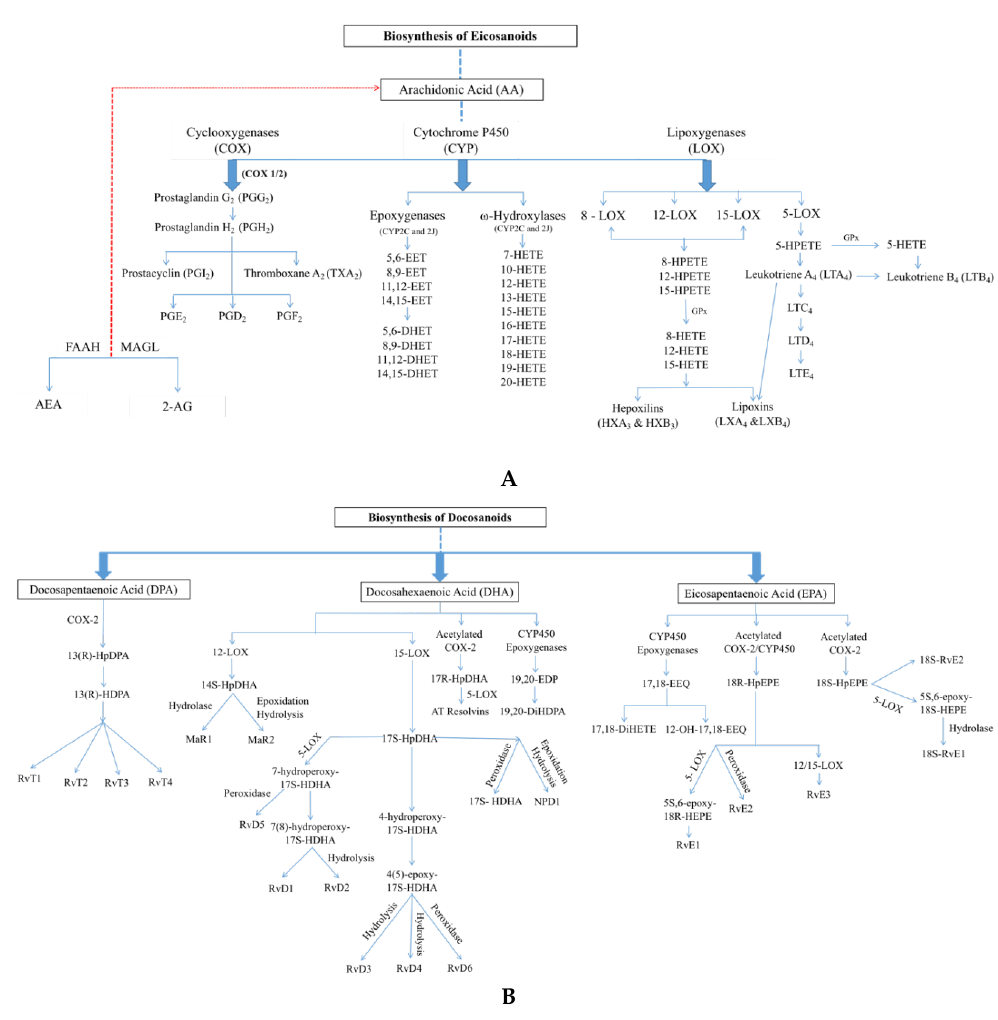
Figure 1. Biosynthesis of eicosanoids and docosanoids. ( A ) Eicosanoid biosynthesis starts with the release of arachidonic acid (AA) from membrane phospholipids and is catalyzed by three major enzyme families: cyclooxygenases (COXs), lipoxygenases (LOXs), and cytochrome P450 epoxygenases (CYPs). COXs produce prostaglandins (PGs) and thromboxanes (TXs) through the actions of specific synthases; LOXs produce biologically active metabolites, such as hydroperoxyeicosatetraenoic acids (HPETEs), hydroxyeicosatetraenoic acids (HETEs), and leukotrienes (LTs), while CYPs metabolize AA into epoxyeicosatrienoic acids (EETs), dihydroxyeicosatrienoic acids (DHETs), and HETEs. Arachidonic acid can be recycled from the breakdown of endocannabinoids through the actions of fatty acid amide hydrolase (FAAH) and monoacylglycerol lipase (MAGL). ( B ) Docosanoids originate from eicosapentaenoic acid (EPA), docosapentaenoic acid (DPA), and docosahexaenoic acid (DHA), which are then converted into a series of lipid mediators, including resolvins, protectins, and maresins. Abbreviations: 2-AG, 2-arachidonoylglycerol; AA, arachidonic acid; AEA, N -arachidonoylethanolamine / anandamide; AT, aspirin-triggered; COX, cyclooxygenase; CYP, cytochrome P450; DHA, docosahexaenoic acid; DHET, dihydroxyeicosatrienoic acid; DiHDPA, dihydroxydocosapentaenoic acid; DiHETE, dihydroxyeicosatetraenoic acid; DPA, docosapentaenoic acid; EDP, epoxydocosapentaenoic acid; EEQ, epoxyeicosatetraenoic acid; EET, epoxyeicosatrienoic acid; EPA, eicosapentaenoic acid; FAAH, fatty acid amide hydrolase; GPx, glutathione peroxidase; HDHA, hydroxydocosahexaenoic acid; HDPA, hydroxydocosapentaenoic acid; HEPE, hydroxyeicosapentaenoic acid; HETE, hydroxyeicosatetraenoic acid; HpDHA, hydroperoxydocosahexaenoic acid; HpDPA, hydroperoxydocosapentaenoic acid; HpEPE, hydroperoxyeicosapentaenoic acid; HPETE, hydroperoxyeicosatetraenoic acid; HX, hepoxilin; LOX, lipoxygenase; LT, leukotriene, LX, lipoxin; MAGL, monoacylglycerol lipase; MaR, maresin; NP, neuroprotectin; OH, hydroxyl group; PG, prostaglandin; RV, resolvin; TX,